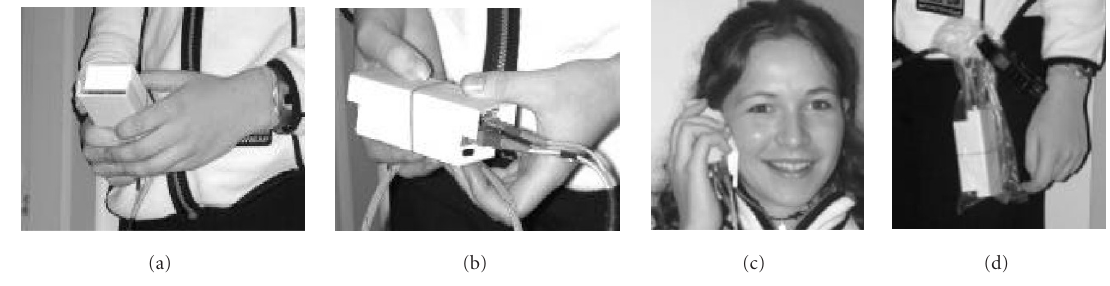
Figure 4: The four ways of handling the handset measurement by a test person. (a) portrait, (b) landscape, (c) at the ear, and (d) at the